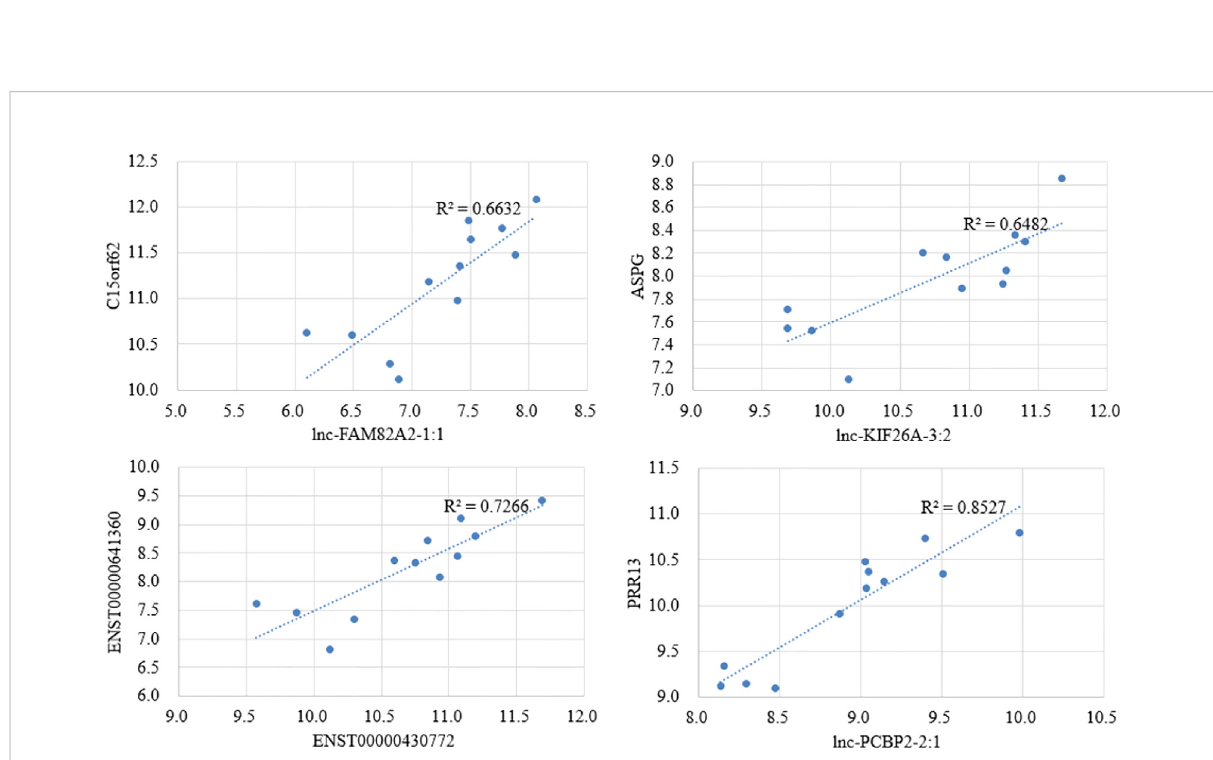
FIGURE 4 Scatter plots for the top 4 highly correlated lncRNA – mRNA pairs by correlation analysis.